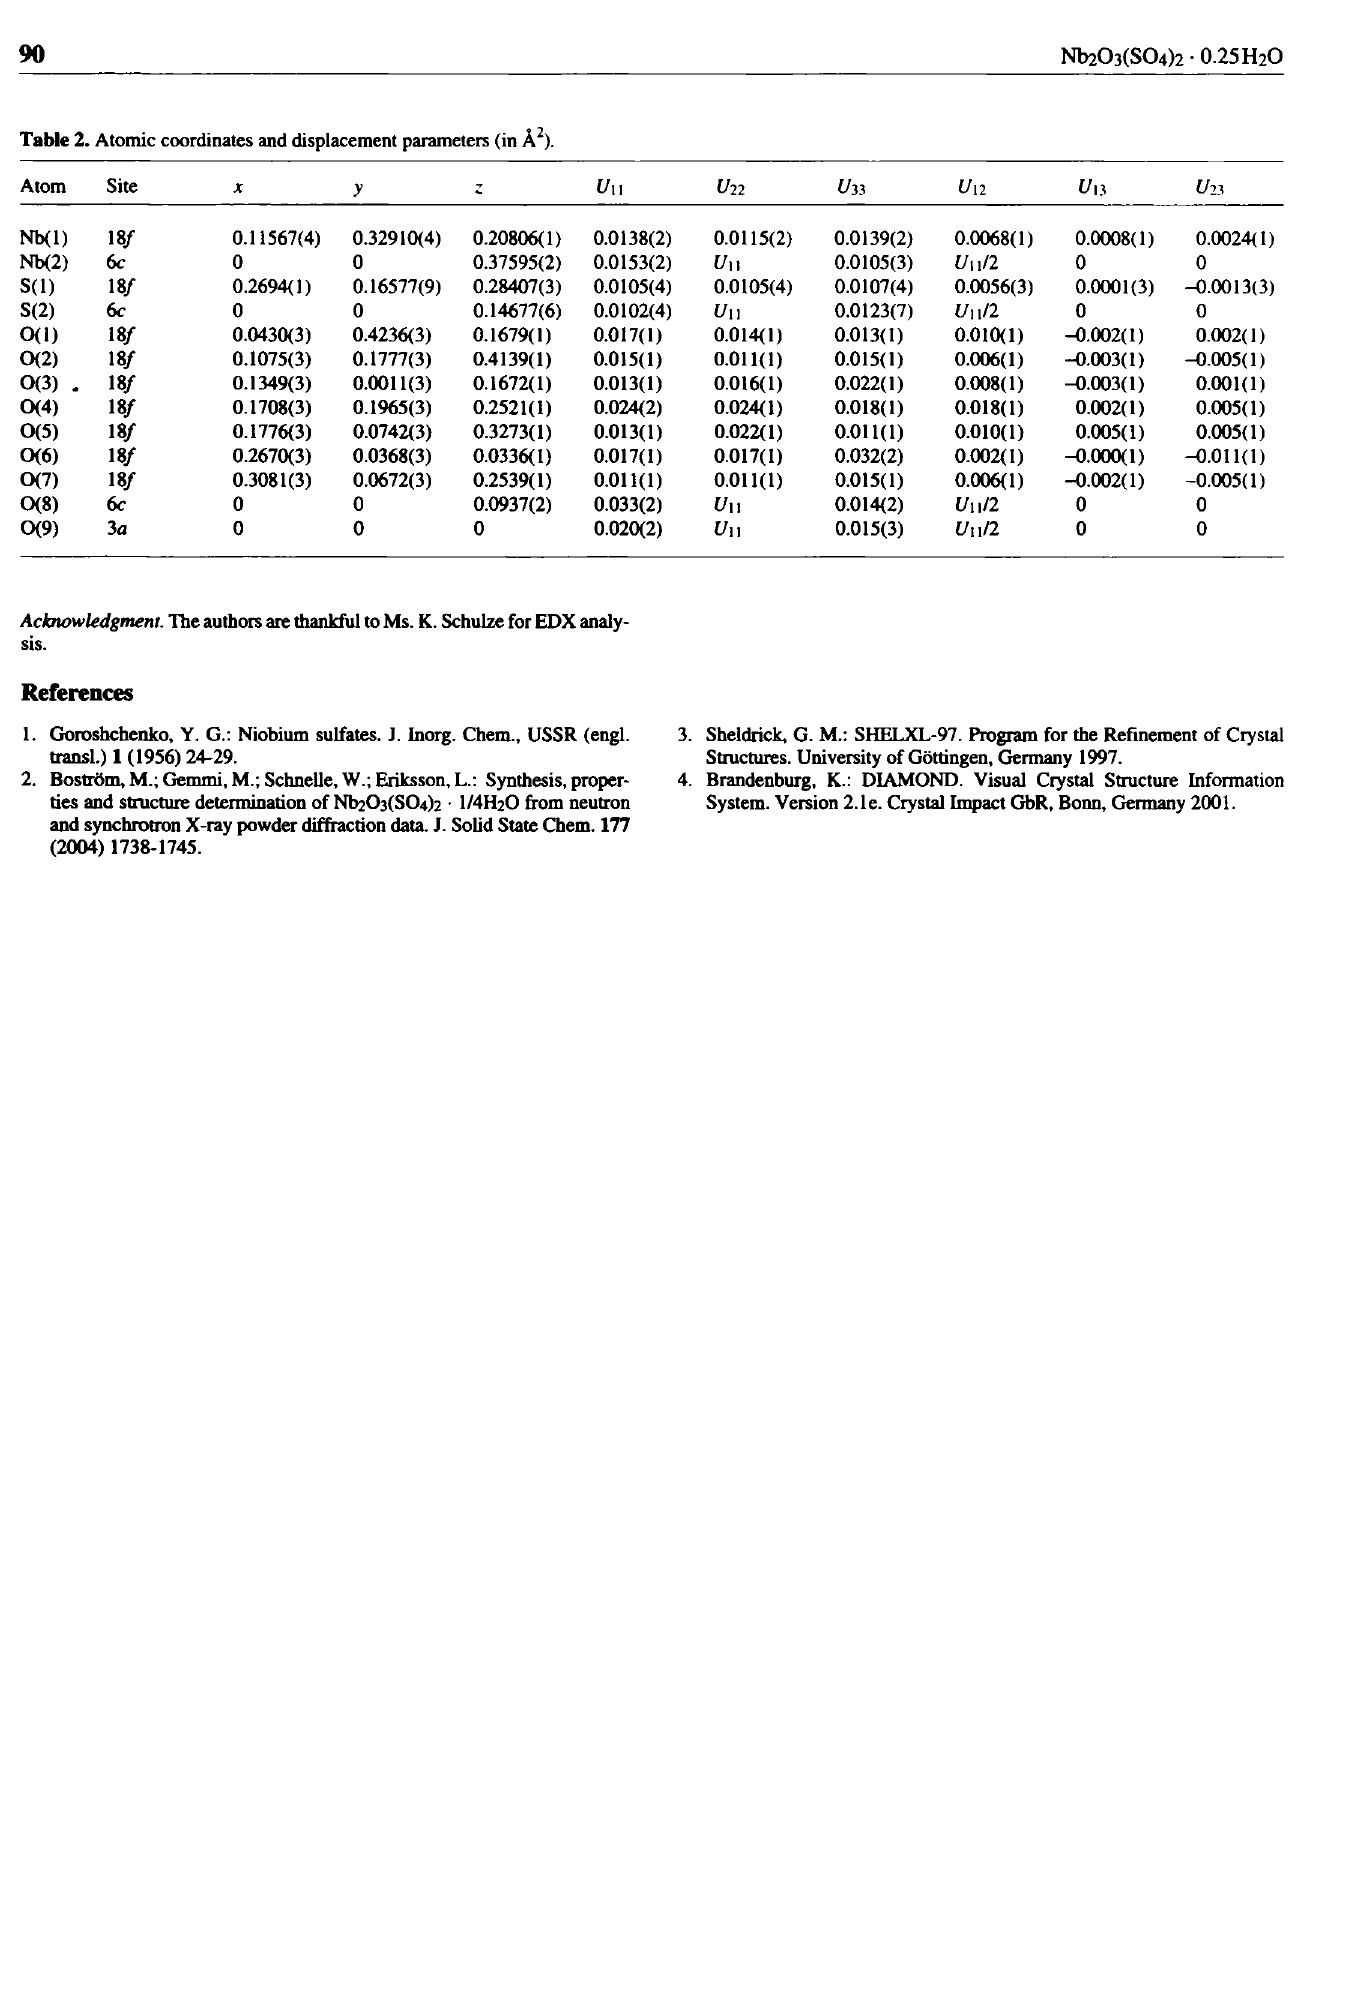
Table 2. Atomic coordinates and displacement parameters (in Ä 2